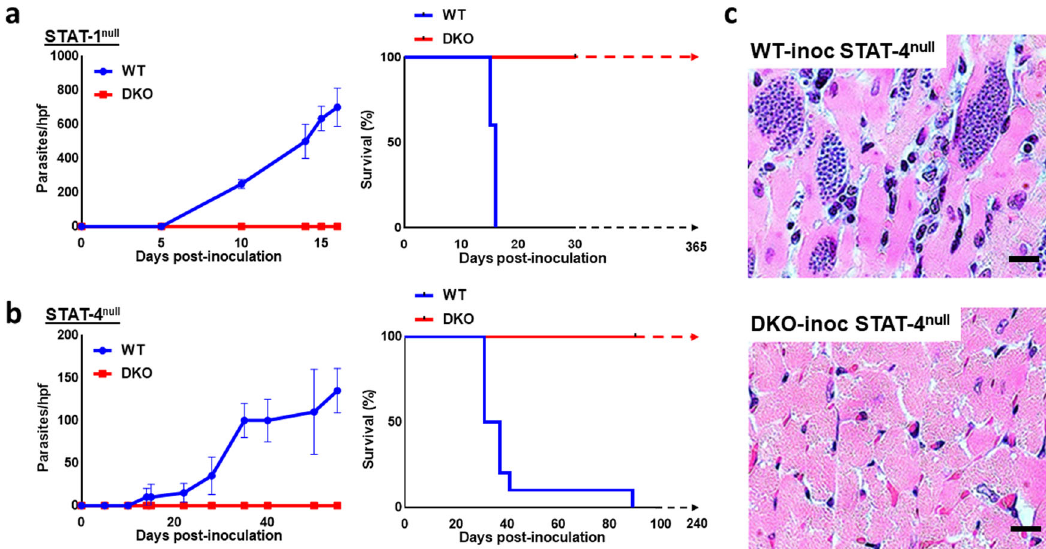
Fig. 4 Inoculation of WT and DKO parasite lines in immuno-de fi cient mouse strains. Both STAT-1 null ( a ) and STAT-4 null ( b ) mice were inoculated with WT and DKO cell-culture-derived metacyclic trypomastigotes (10 5 parasite per IP inoculation per mouse) and followed for parasitemia (left panels), survival (middle panels). Data demonstrates that WT parasites increase in the blood over the course of infection until death between 15 – 16 days (for STAT-1 null animals) or between 31 – 89 days (in STAT-4 null animals). Inoculation of either mouse strain with DKO parasites does not lead to clinical disease. Only WT parasites, but not DKO-parasites, were found in tissues either by histopathologic analysis (as shown in heart sections of STAT-4 null animals in panel c ) or in explantation culture of animals at 6 months post-infection (Table in Supplementary Fig. 9). Hpf, high powered fi eld. This is a compilation of data from 3 separate experiments in the STAT-1 null mice and twice in the STAT-4 null mice, each with comparable results (5 mice per group in each experiment, n = 15 or 10, respectively). P < 0.05 in both Kaplan – Meier curves and in parasitemia analysis (2 – 3 mice per group per experiment, mean values and SD are shown for each